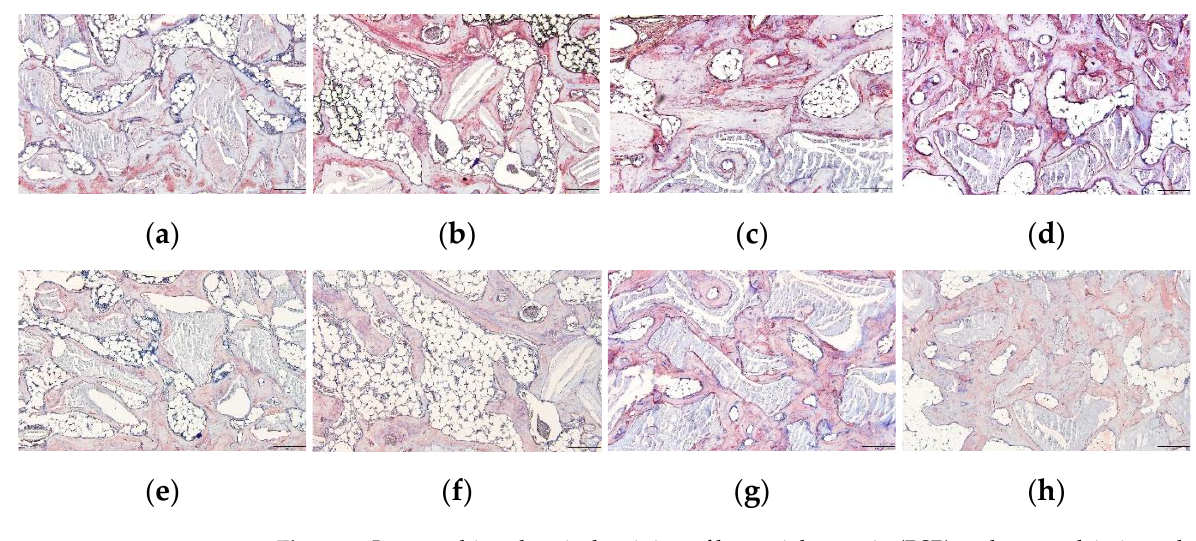
Figure 5. Immunohistochemical staining of bone sialoprotein (BSP) and osteocalcin in each group. (BSP; a – d ) and osteocalcin ( e – h ) after surgical intervention. ( a , e ) 6w particle, ( b , f ) 6w block, ( c , g ) 16w particle, and ( d , h ) 16w block groups. High expression levels of BSP and osteocalcin were ob- served in the newly formed bone (original magnification 100×, bar = 200 µm).